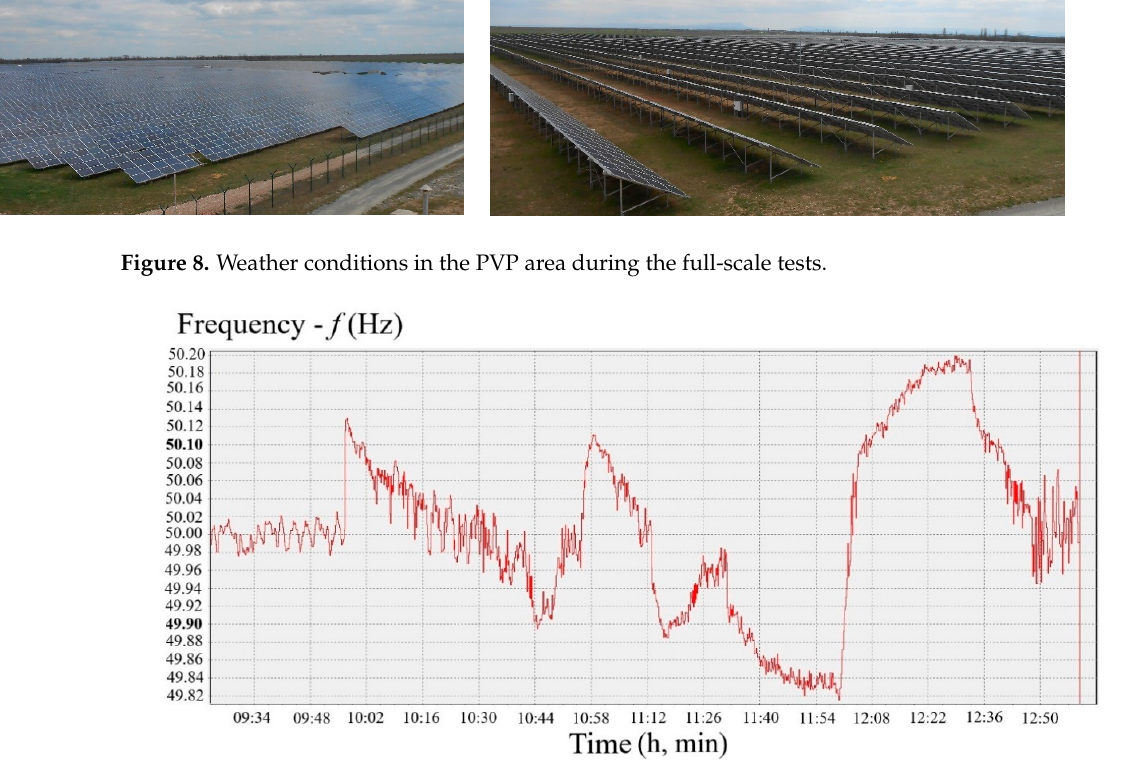
Figure 9. Graph of a frequency change after islanding part of the power system.